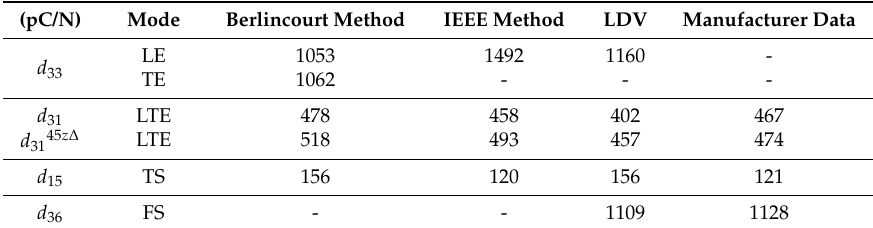
Table 4. Characterisation of piezoelectric constant d ij on Mn:PIN-PMN-PT under ambient conditions with different vibration modes measured with different